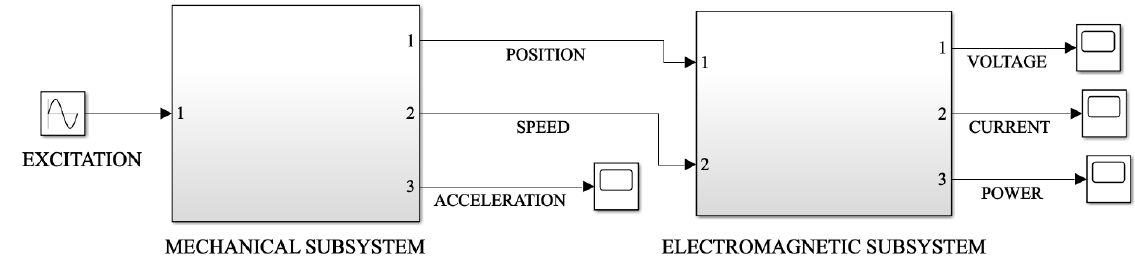
Figure 3. Simulink block